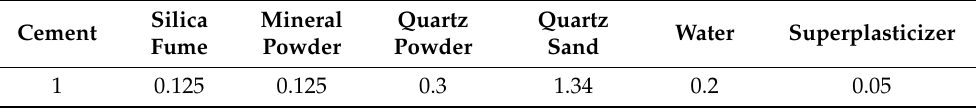
Table 2. Mix proportions of UHPC